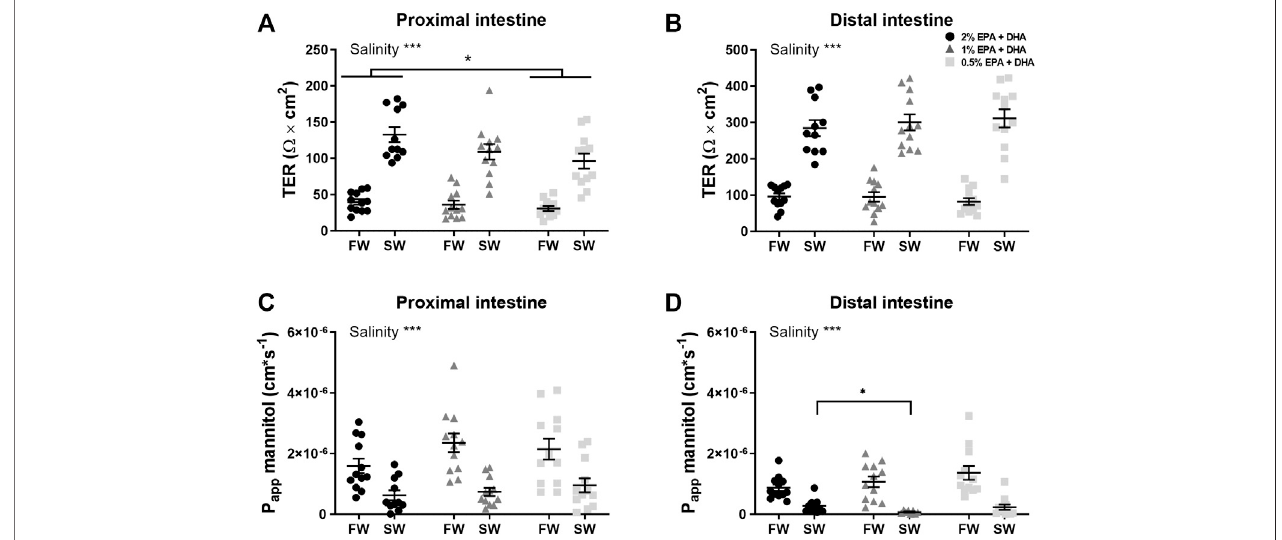
FIGURE 1 | Barrier function assessed as transepithelial electrical resistance (TER; (A,B) and apparent permeability coef fi cient (P app ) for 14 C-mannitol (C,D) in proximal and distal intestine of freshwater (FW) smolts and seawater (SW) acclimated Atlantic salmon fed different levels of omega-3. Statistics: 2-way ANOVA where main effects were compared with Tukey´s multiple comparisons test. Signi fi cant effects from the post-hoc test are reported as * p < 0.05 and *** p < 0.001. Data are presented as individual values with the horizontal line representing the mean and the vertical lines SEM.